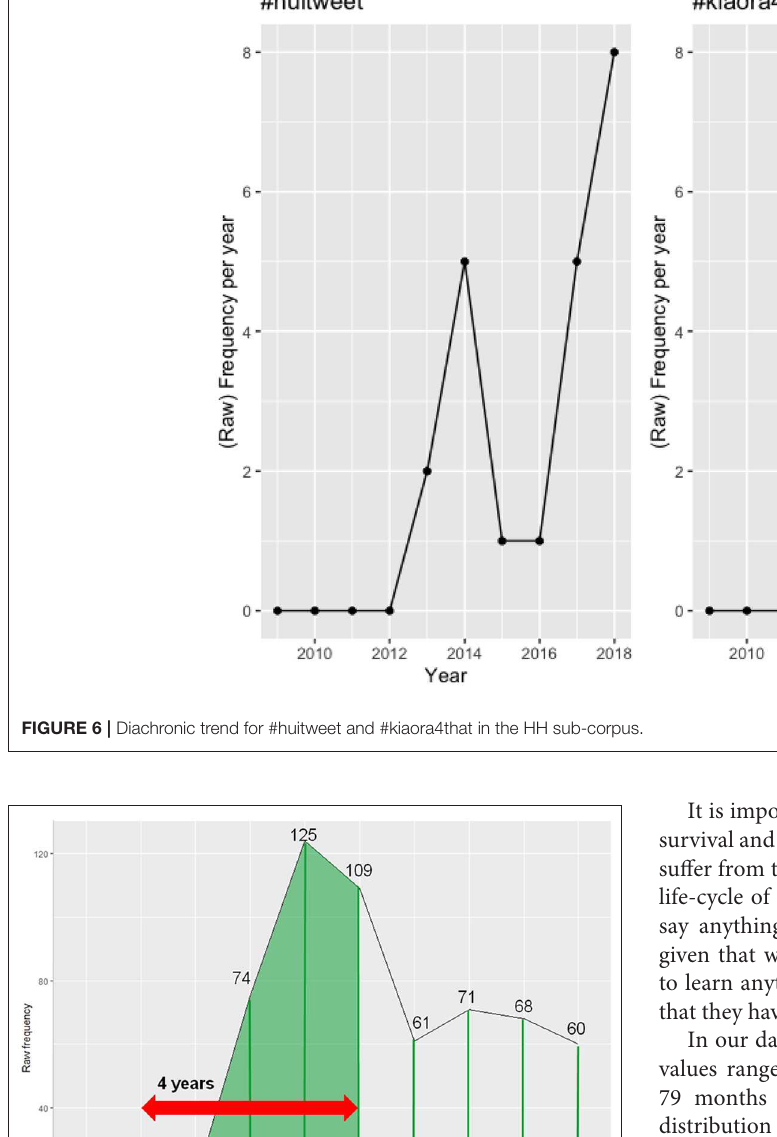
Returning to Figure 6 , #huitweet has a half-life of 4 years, whereas #kiaora4that has a half-life of 1 year, reflecting the different nature of their frequency distributions. We chose to measure half-lives of hybrid hashtags in our corpus across number of months in a bid to obtain the most fine-grained measurement (more accurate than years) while still avoiding data sparsity issues (which arose when considering number of